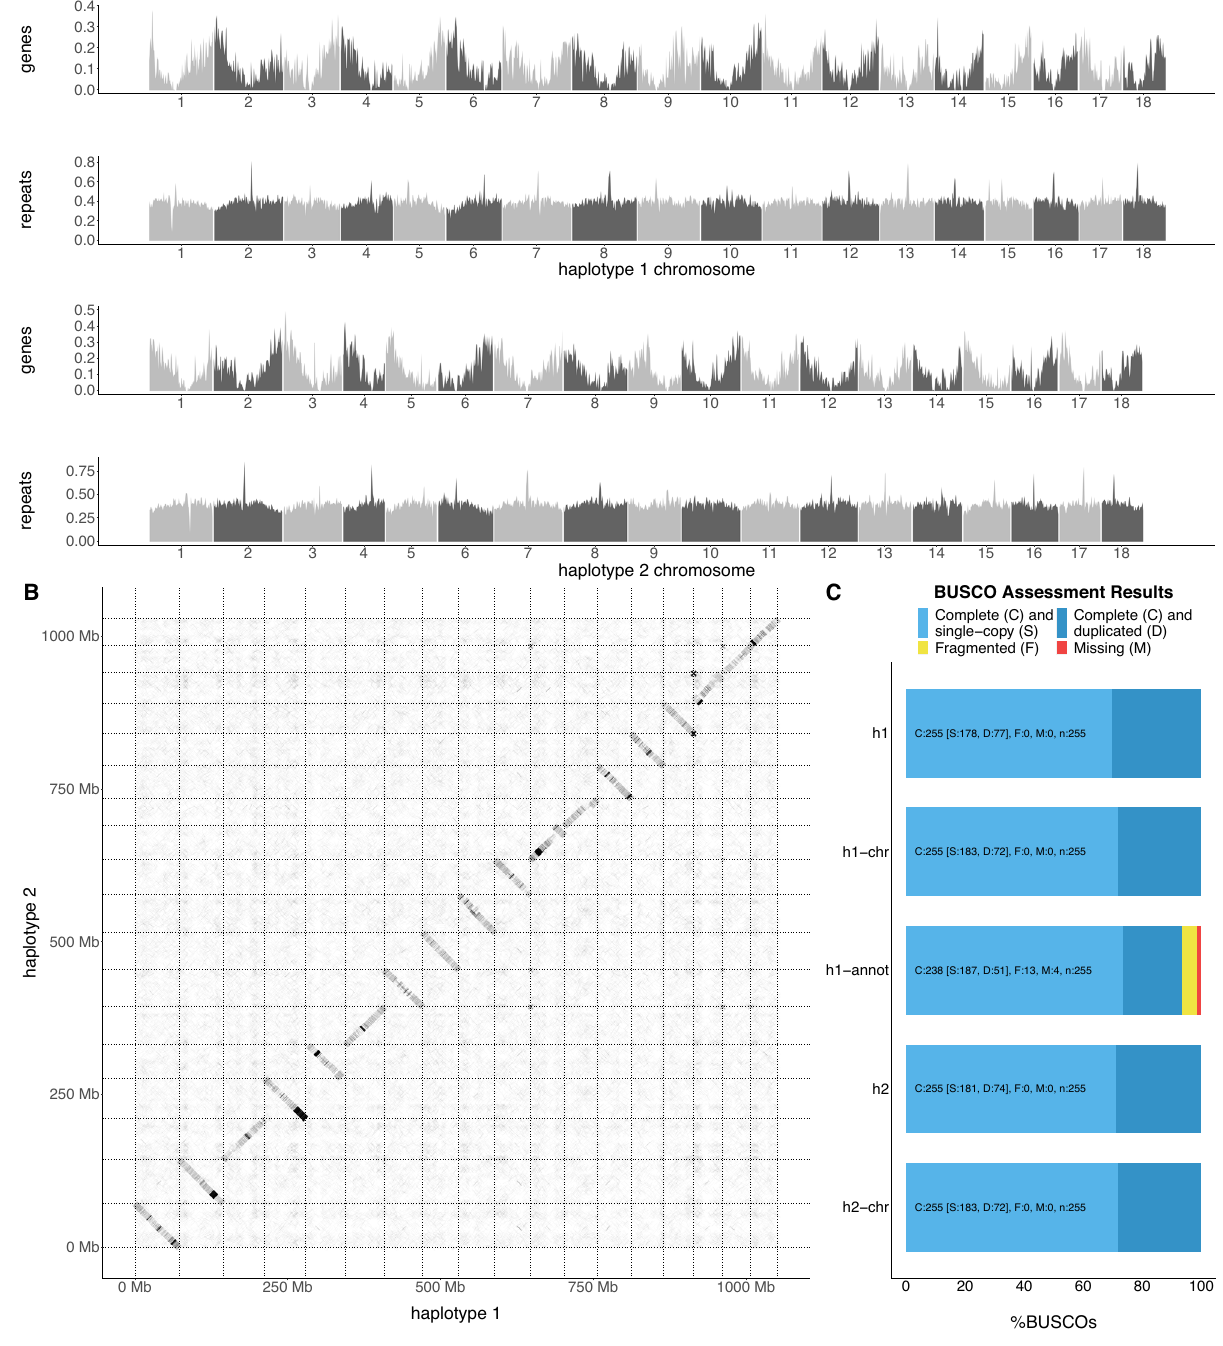
Fig. 1 | A phased diploid genome assembly of Ambrosia artemisiifolia . A The distribution of gene and repeat density in 1Mbp windows across the 18 chromo- somes of eachhaplotype. B Alignmentsof the 18chromosomesofeachhaplotype. C Benchmarking Universal Single-Copy Orthologs (BUSCO) results for each